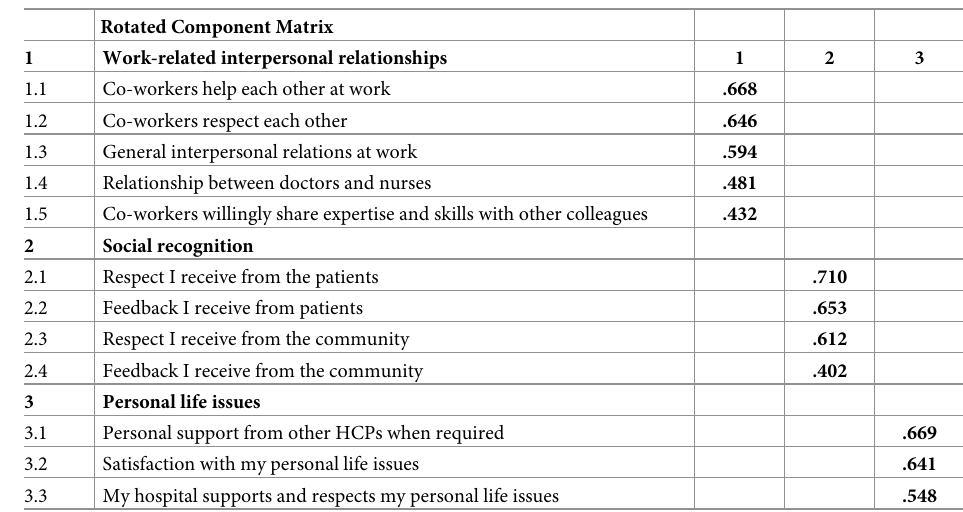
Table 3. Socio-cultural